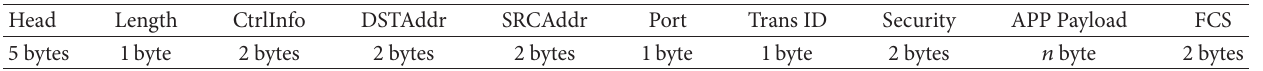
Table 2: Communication frame structure.